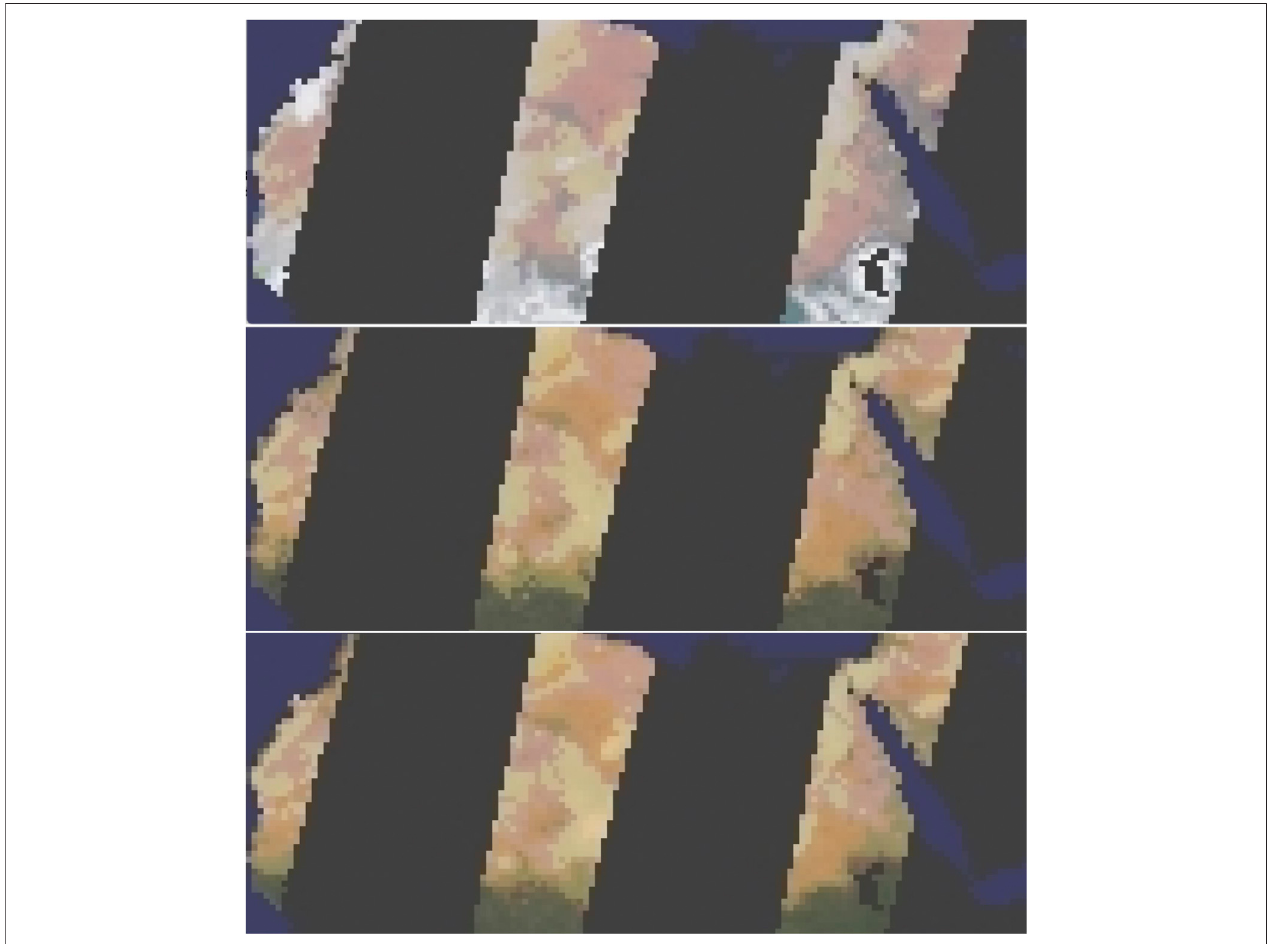
FIGURE8| Similarto Figure7 butzoomedinonnorthernAfrica;Top:GOME-2RGBimagefromAugust2,2018;Middle:ReconstructedsurfaceRGBimagefrom GOME-2; Bottom: Surface RGB from MODIS MCD43 averaged over GOME-2 pixels.